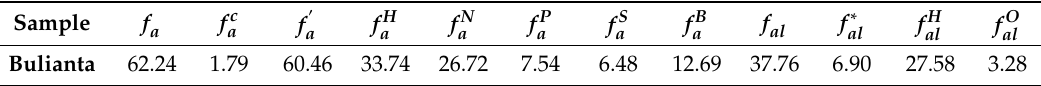
Table 3. Structural parameters derived from 13 C-NMR for the Bulianta coal sample 1 .